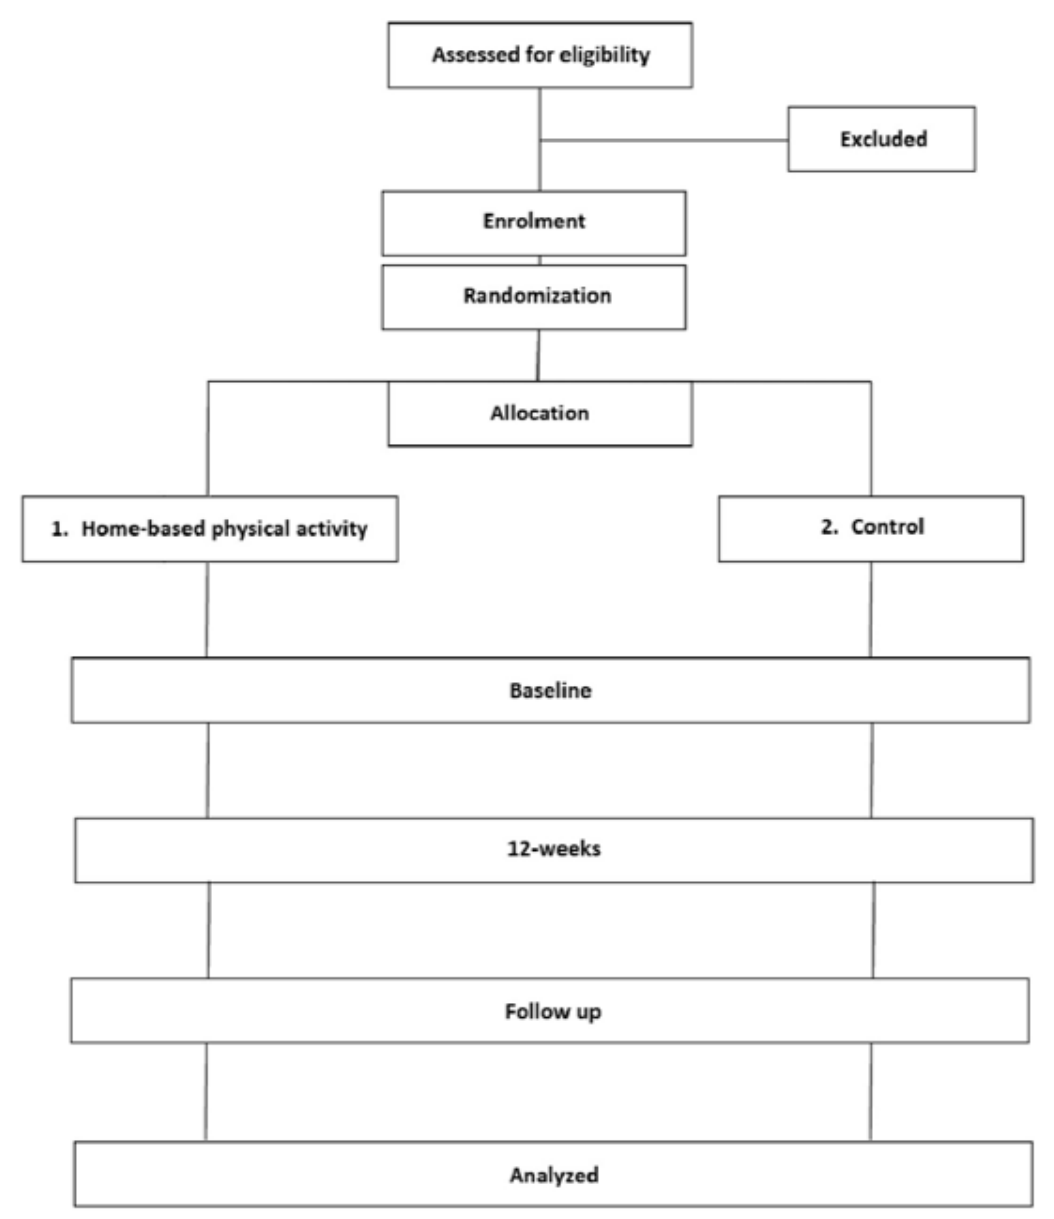
Figure 1. Consort diagram showing the study design.